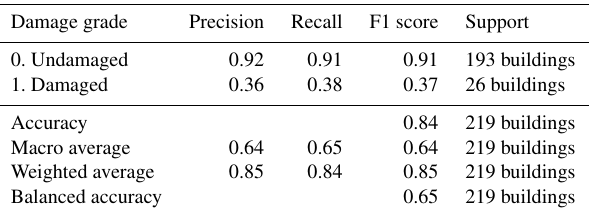
Table 5. Test-set performance metrics for binary classification for the 2017 Puebla